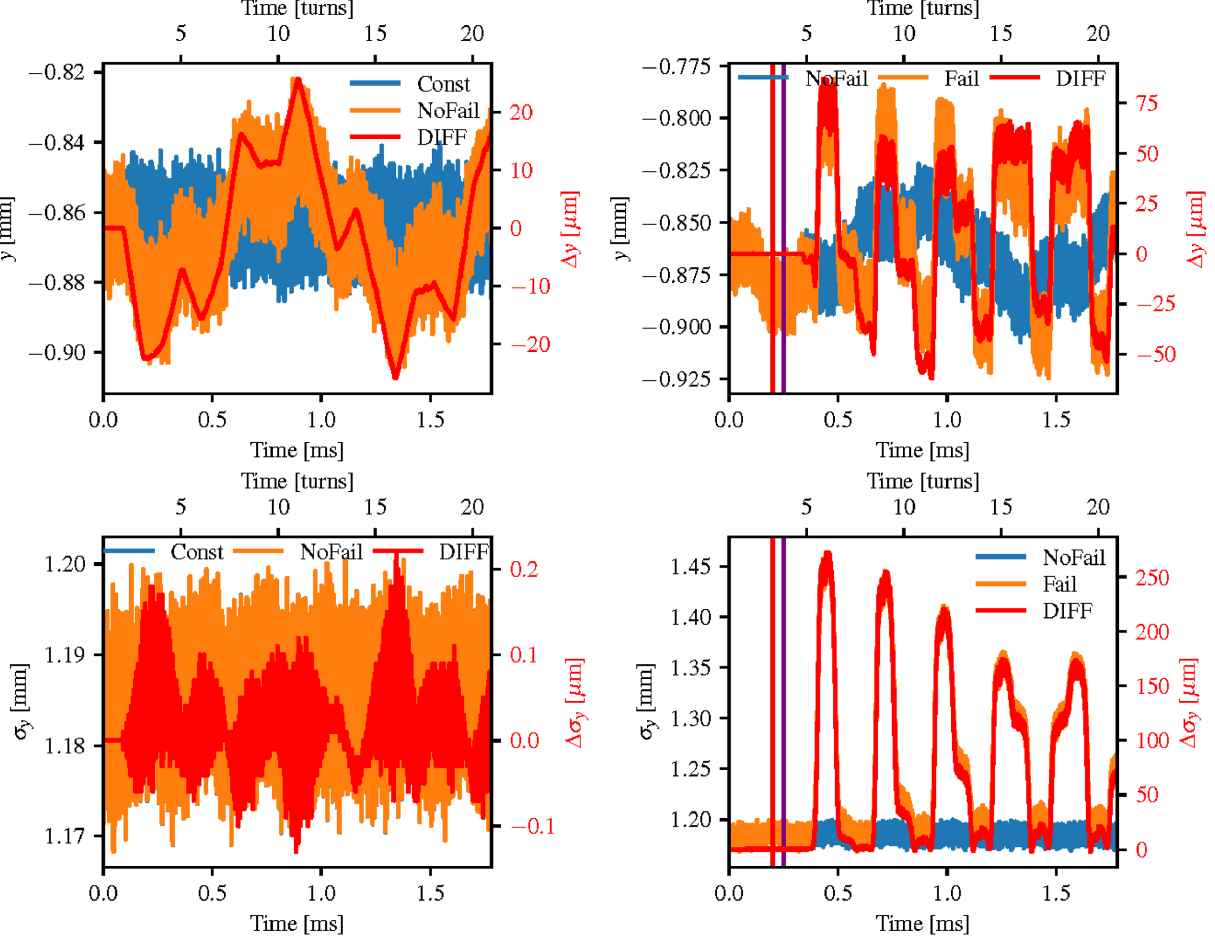
FIG. 16. Vertical beam position (top) and size (bottom) at the controlled crab cavity in the LHC, comparing scenarios NoFail vs Const (left) and Fail vs NoFail (right). For the Fail scenario, the first vertical line (red) marks the beginning of the quench, and the second line (purple) the time when pressure detuning becomes